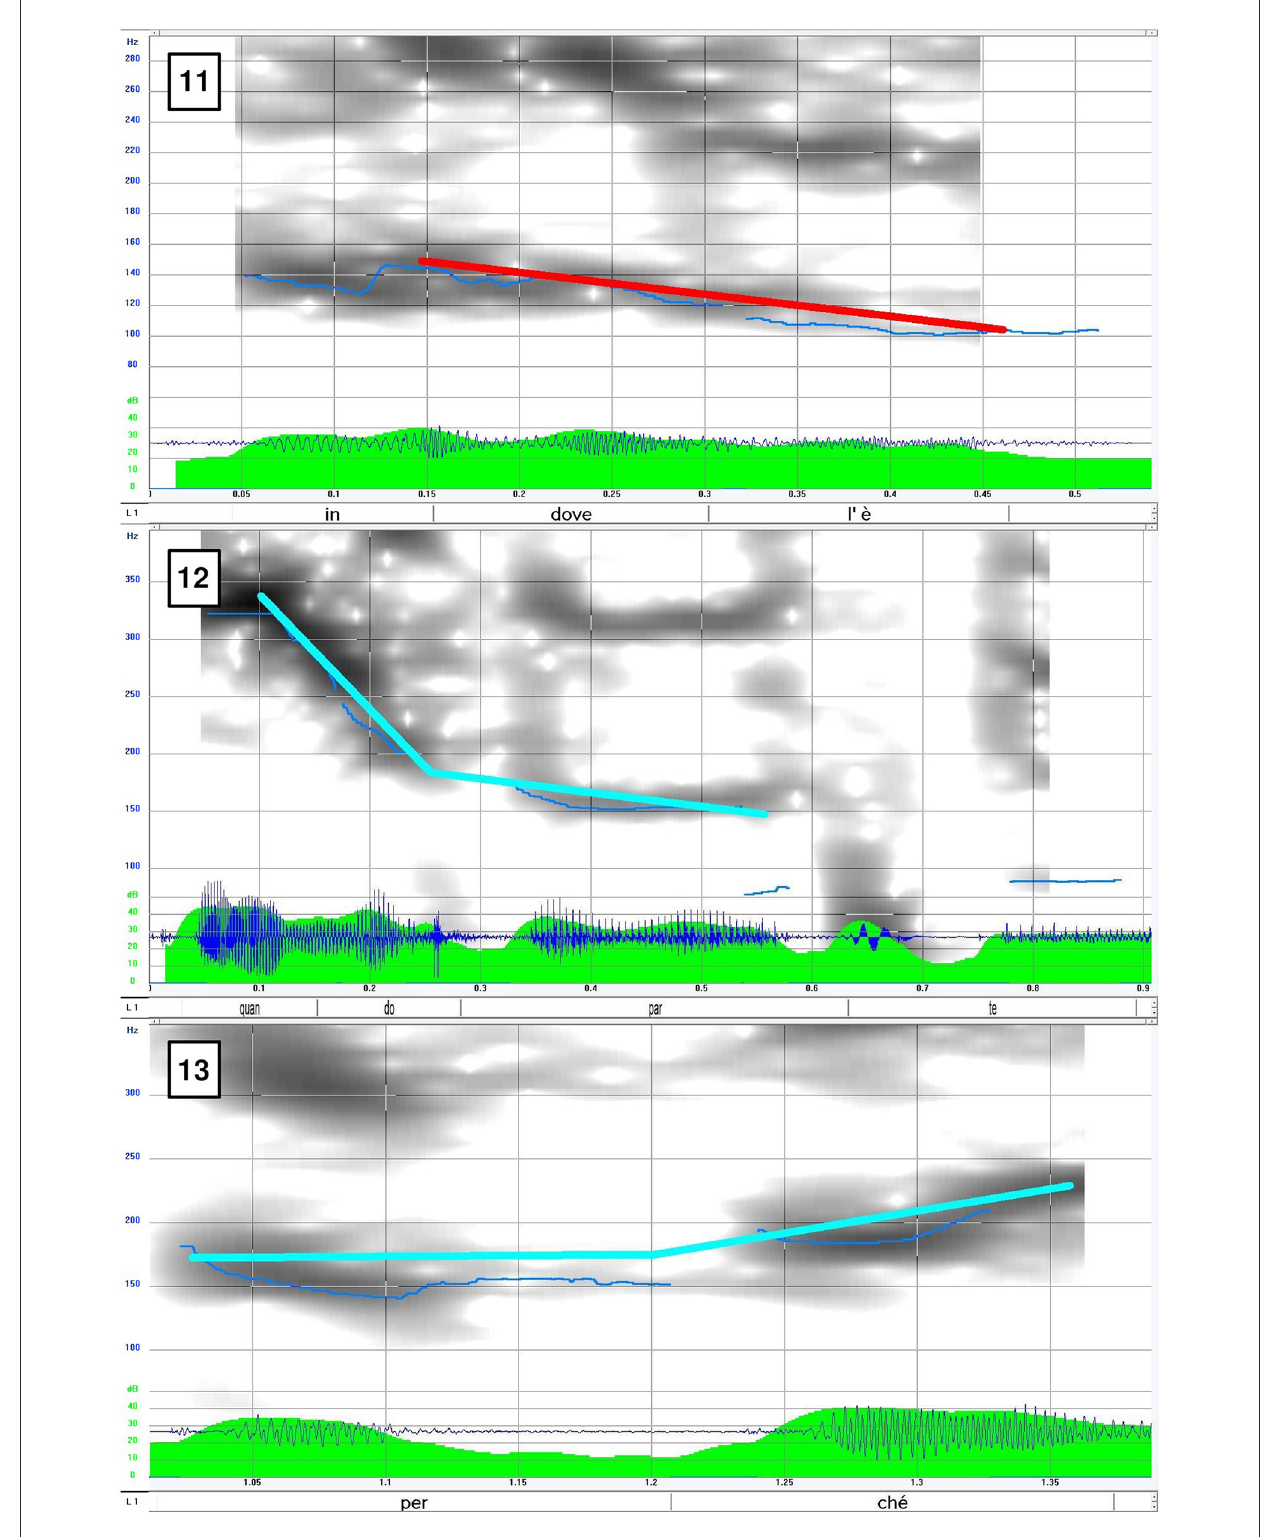
FIGURE8 Prototypic contours of Partial questions in Italian (11–13) (Supplementary Audio 6.wav).